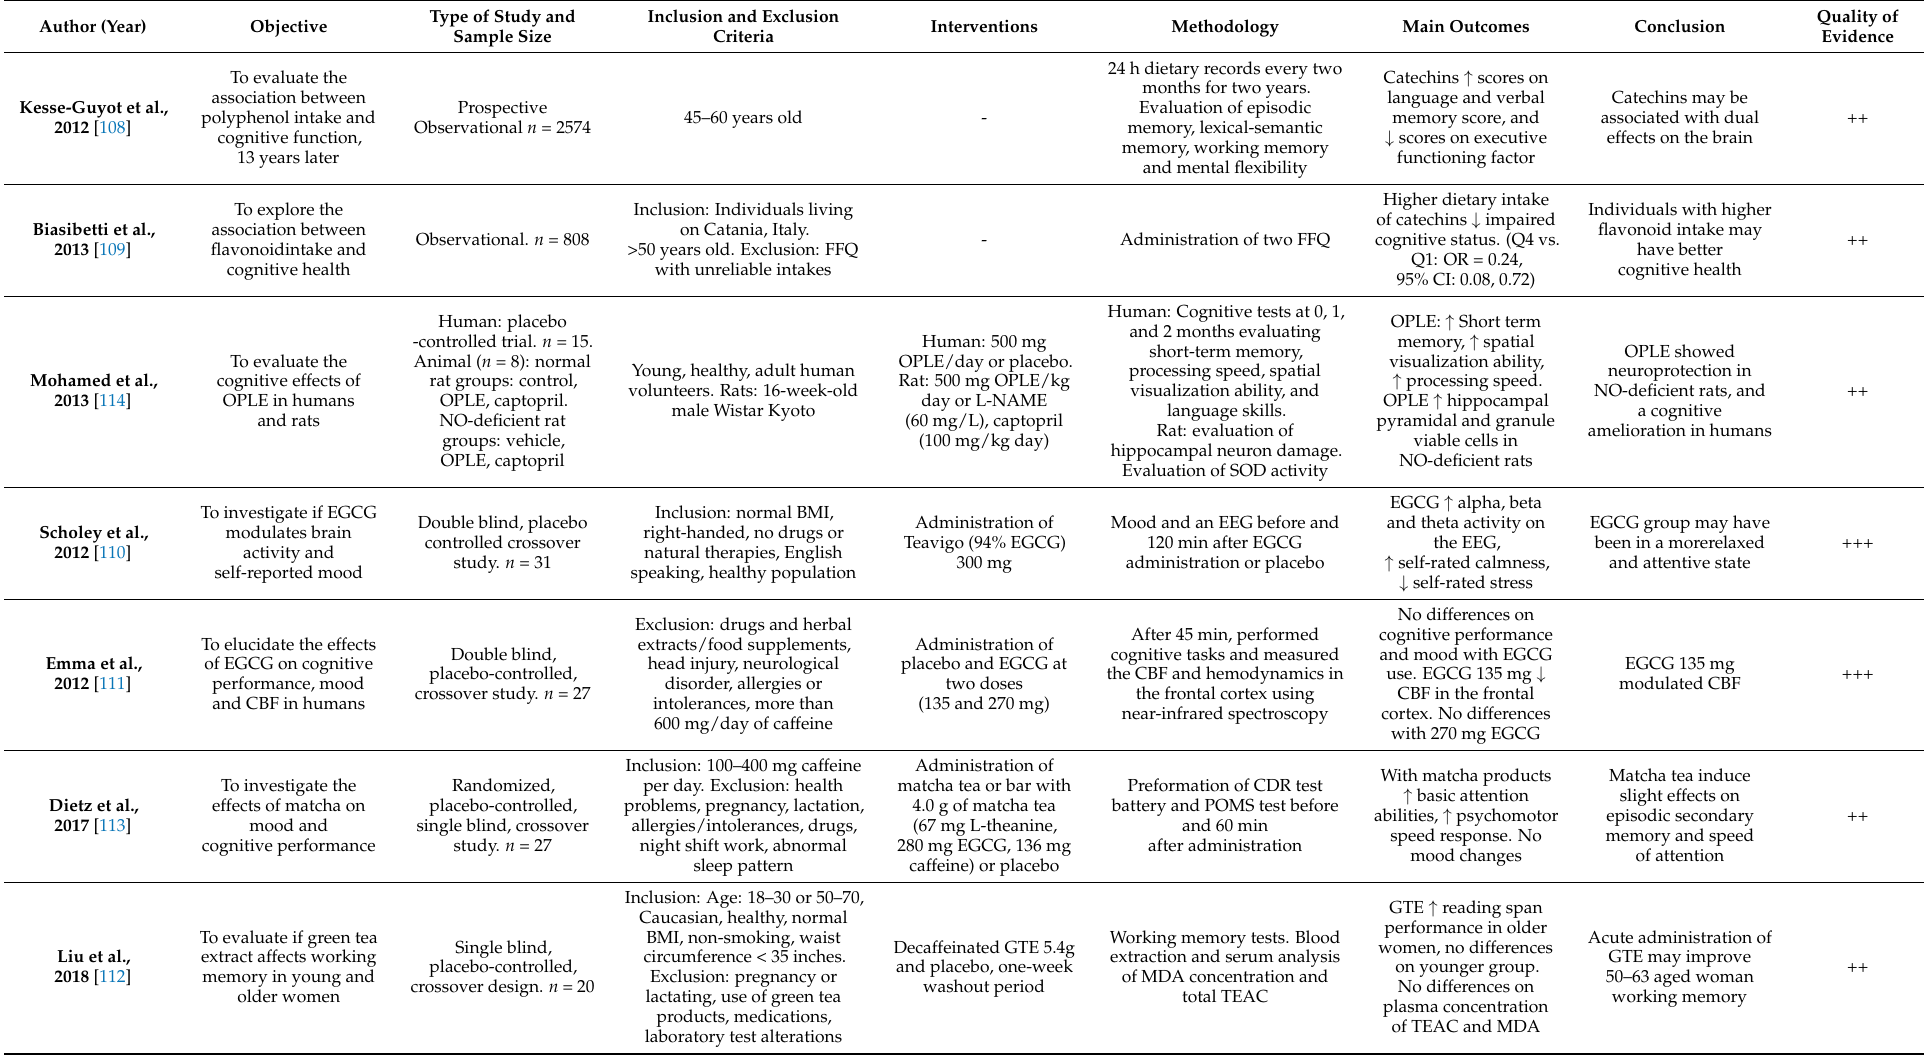
Table 4. Neurologic effect of catechins on healthy